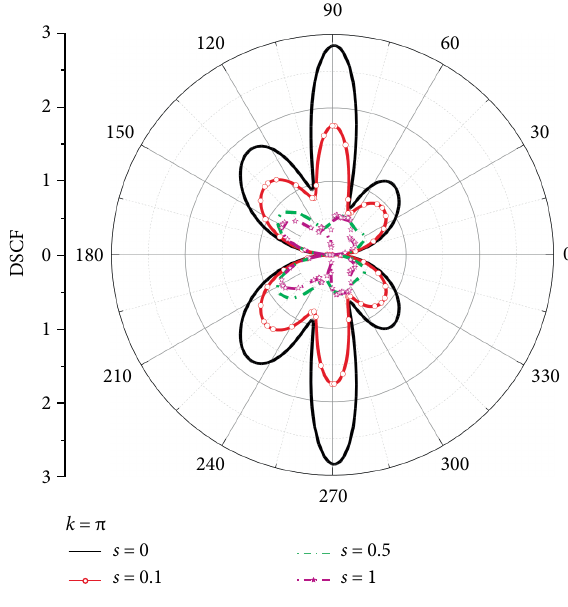
Figure 6: Distributions of DSCF around an elliptic hole with various 𝑠 for 𝑎 = 1 , 𝑏 = 0.6 , 𝐾 = 𝜋